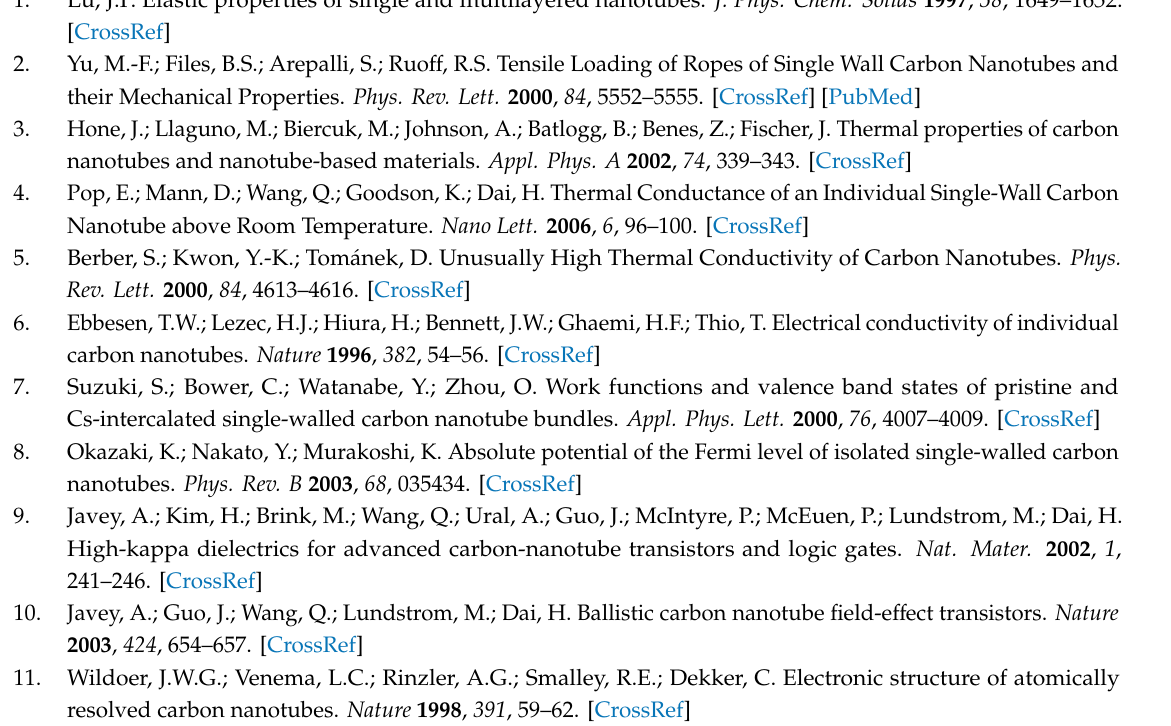
Figure S1: (a) SEM image of single walled carbon nanotubes (SWCNT) f-S1_Ag; images of the distribution of (b) Fe nanoparticles; and (c) Ag nanoparticles, as obtained by energy dispersive spectroscopy (EDS) mapping, Table S1: Atomic percentages of the deconvoluted peaks of C 1s high resolution X-ray photoelectron spectroscopy (XPS) spectra, Figure S2: High resolution XPS spectra of C 1s peaks of ( a ) purified samples before and after functionalization and as-received SWCNT; ( b ) non-purified samples of functionalized and as-received SWCNT, Figure S3: Deconvolution of high resolution XPS spectra of C 1s peaks of the amine-functionalized SWCNT, Figure S4: Radial breathing mode (RBM) peaks for the amine functionalized and as-received SWCNT at laser energy of (a) 2.33 eV; (b) 1.96 eV; and (c) 1.58 eV, Table S2: Estimated diameters, at di ff erent laser excitation, for as-received and functionalized